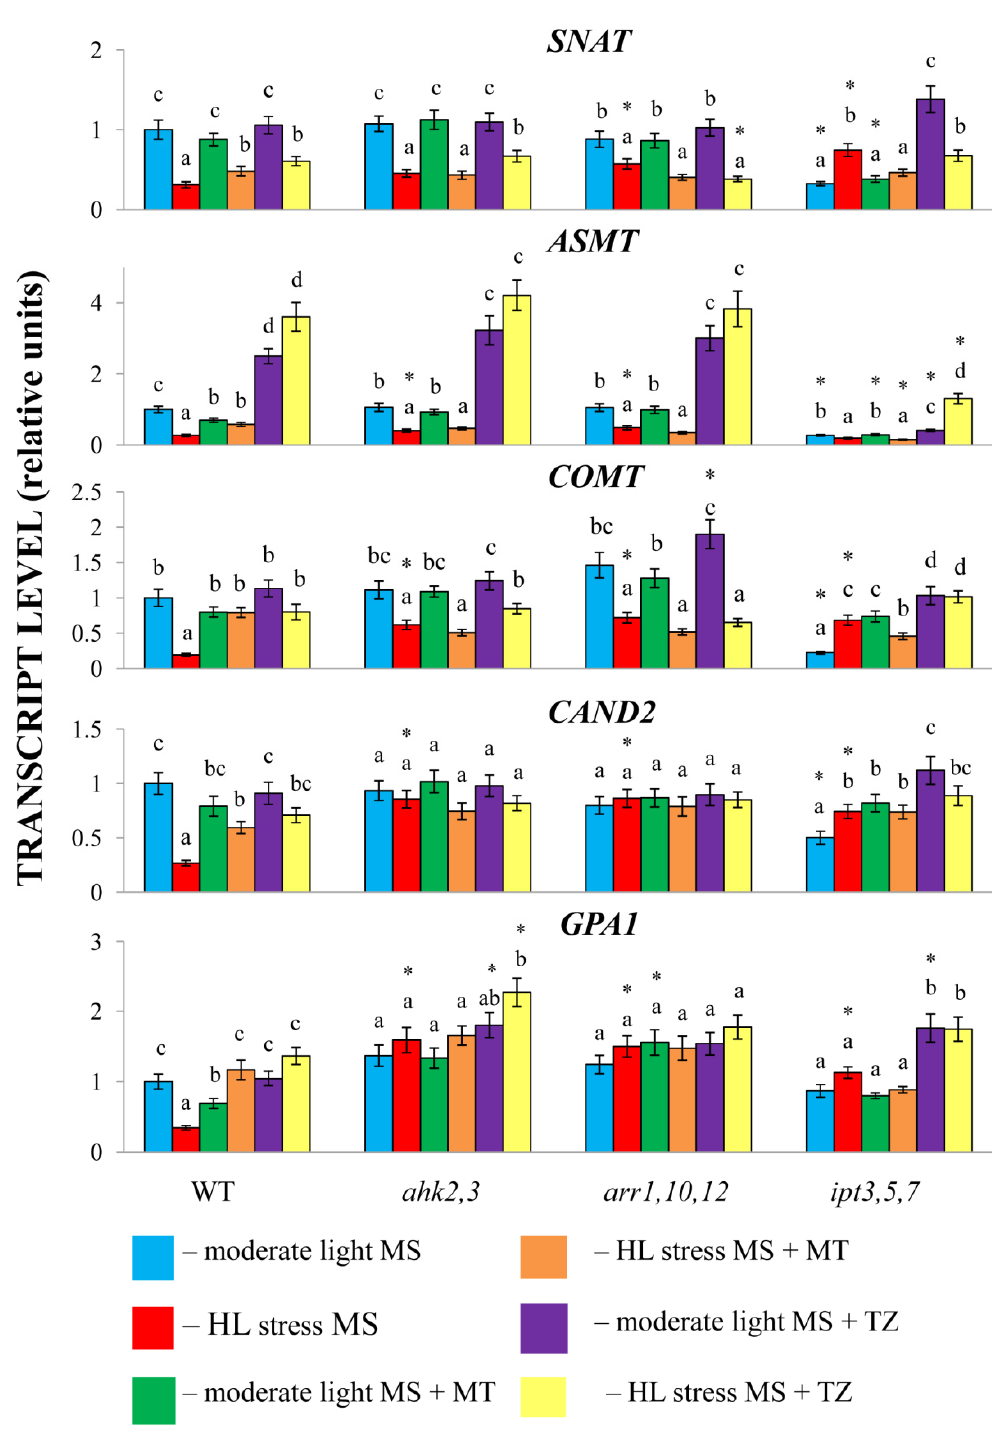
Figure 4. Effect of HL stress and melatonin and trans -zeatin treatment on the expression of melatonin synthesis and signaling genes. The data presented in the figure are the mean values ( n ≥ 3). Error bars represent SEs. Different letters denote statistically significant differences among variants within the same genotype at p < 0.05 (ANOVA with post hoc Tukey’s multiple-comparison test). Asterisks indicate statistically significant differences between the mutants and the wild-type under the corresponding type of treatment at p < 0.05 ( t test).